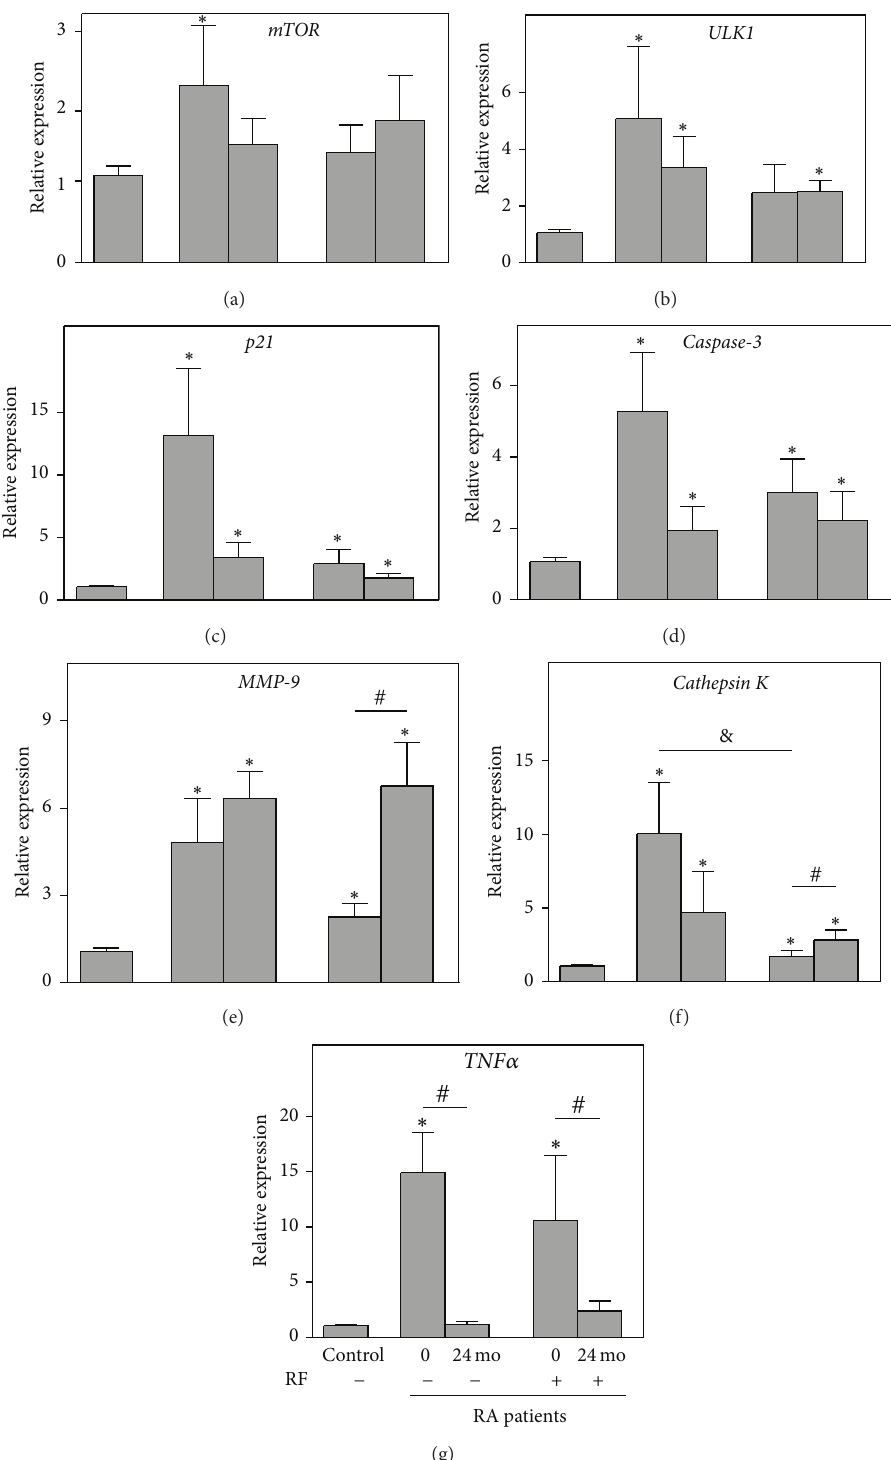
Figure 1: Relative expression of the genes mTOR (a), ULK1 (b), p21 (c), caspase-3 (d), MMP-9 (e), and cathepsin K (f), and TNF 𝛼 (g) with reference to 𝛽 - actin determined by real-time PCR analyses in the whole blood of seronegative (RF − ) ( 𝑛 = 12 ) and seropositive (RF+) ( 𝑛 = 21 ) rheumatoid arthritic patients compared with healthy controls (Control) ( 𝑛 = 35 ) at baseline (0) and after 24 months of follow-up (24mo). Control bar is shown as 1.0 as required for relative quantification with the real-time PCR protocol. Asterisks indicate significant differences from the control in pairwise comparisons (Mann-Whitney U test). Number sign (#) shows significant difference from the baseline value (Wilcoxon matched pairs test). & sign indicates significant difference between seronegative and seropositive RA patients (Mann-Whitney 𝑈